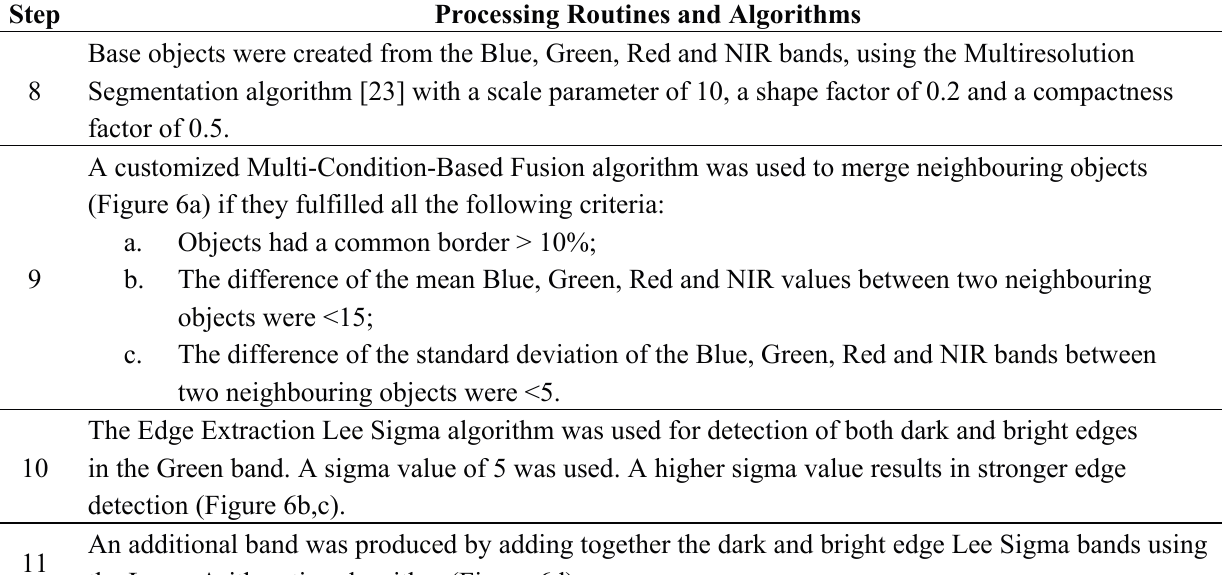
Table 2. Processing routines and algorithms used to create base objects, produce edge extraction bands, and detect bright and dark lines. Processing Routines and